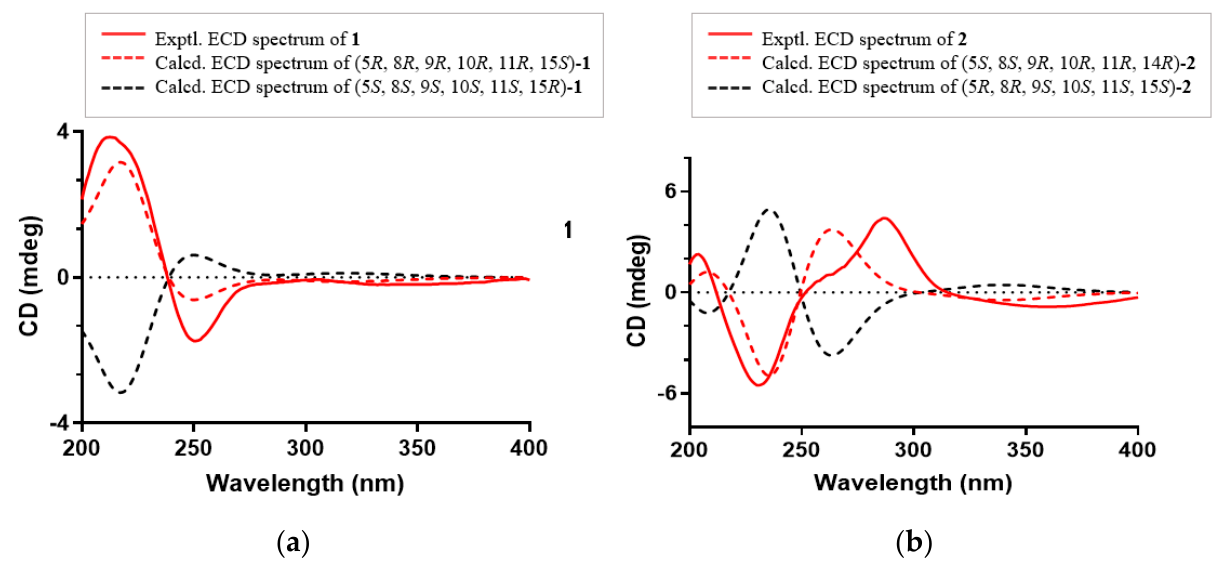
Figure 5. ( a ) Experimental and calculated ECD spectra of 1 ; ( b ) Experimental and calculated ECD spectra of 2 .